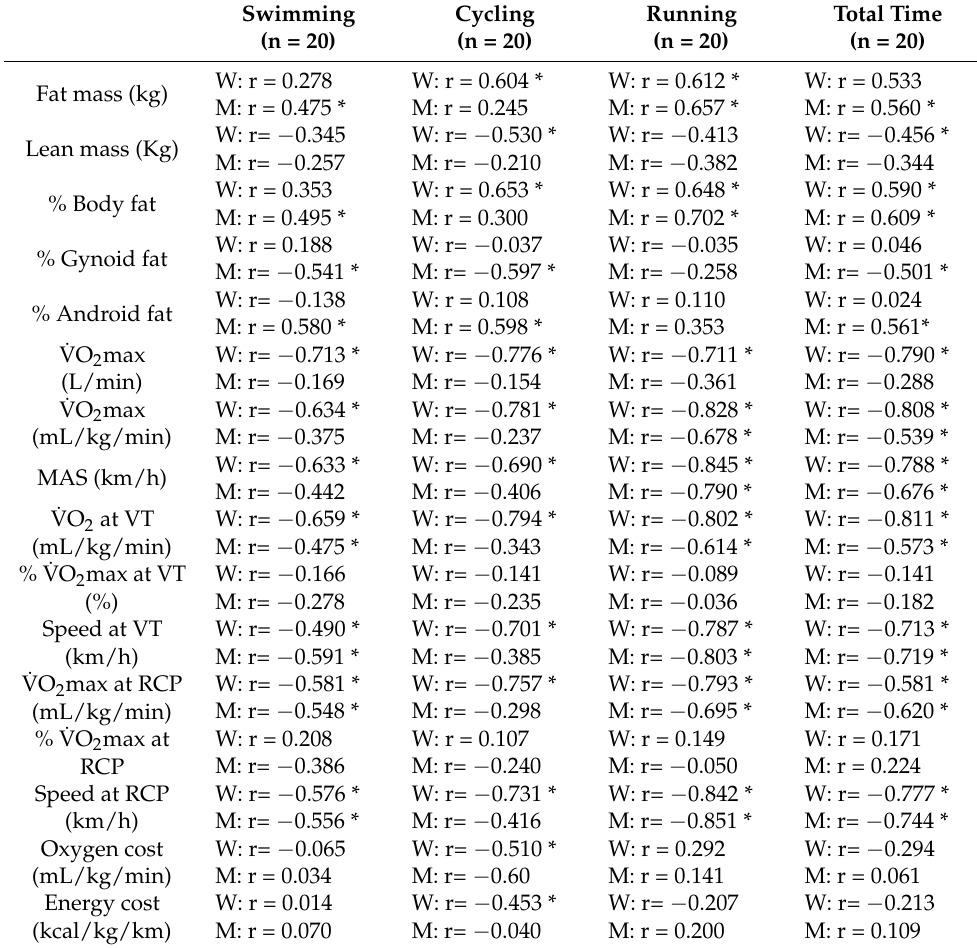
Table 3. Pearson’s correlation coefficient between performance in swimming, cycling, running, total race time, and measured variables for both